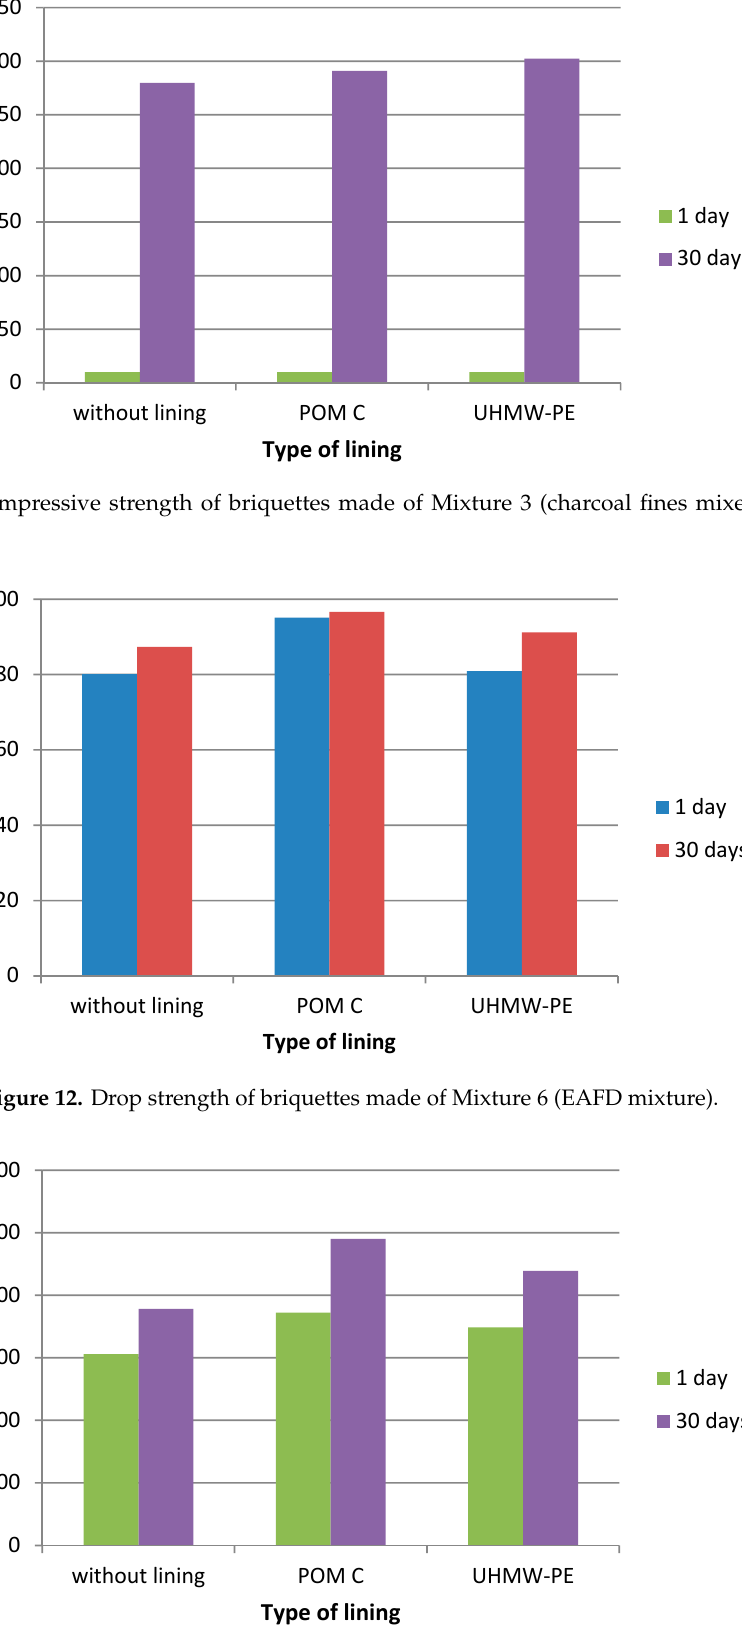
Figure 13. Compressive strength of briquettes made of Mixture 6 (EAFD mixture).